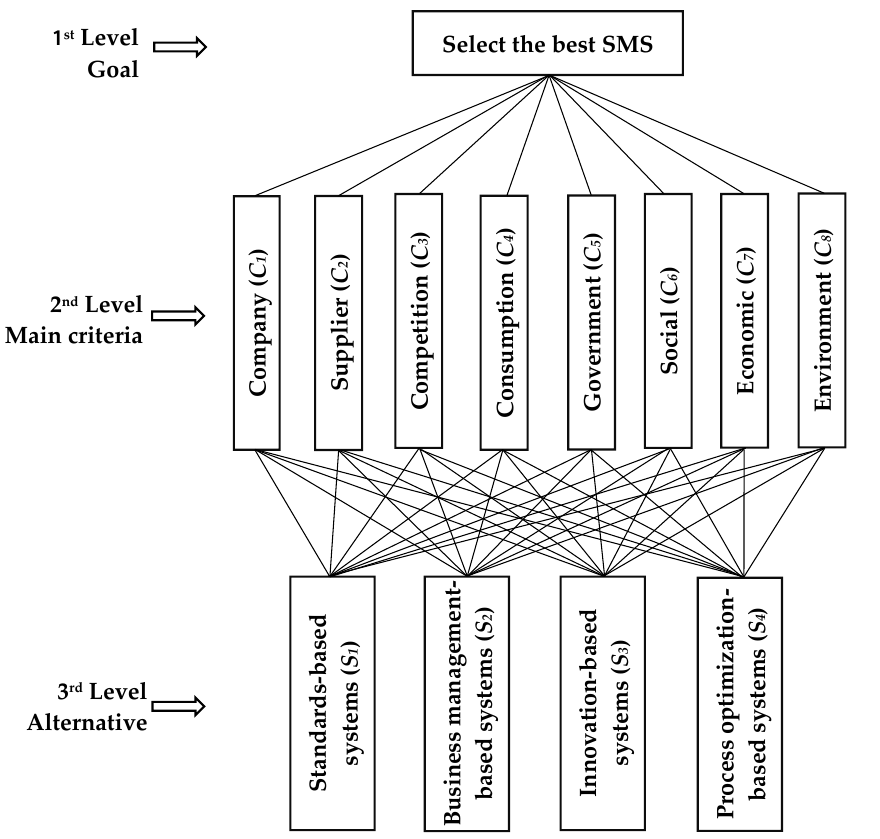
Figure 1. The hierarchical structure of sustainability management system selection.